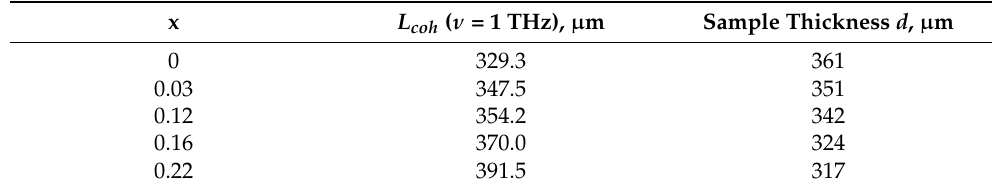
Table 2. Calculated coherence lengths L coh ( ν =1 THz) for GaSe:S crystals and measured thicknesses of the prepared samples.